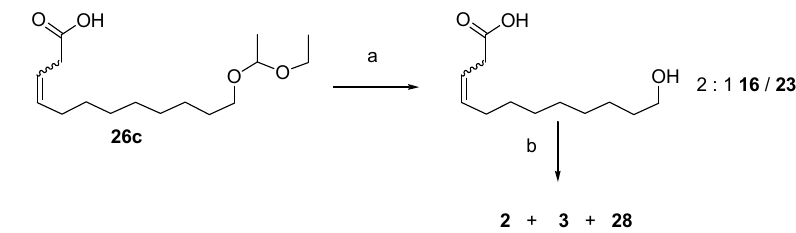
Scheme 4. Synthesis of 2:1 E : Z- lactone 2 and 3 via carboxyacetal 26c .